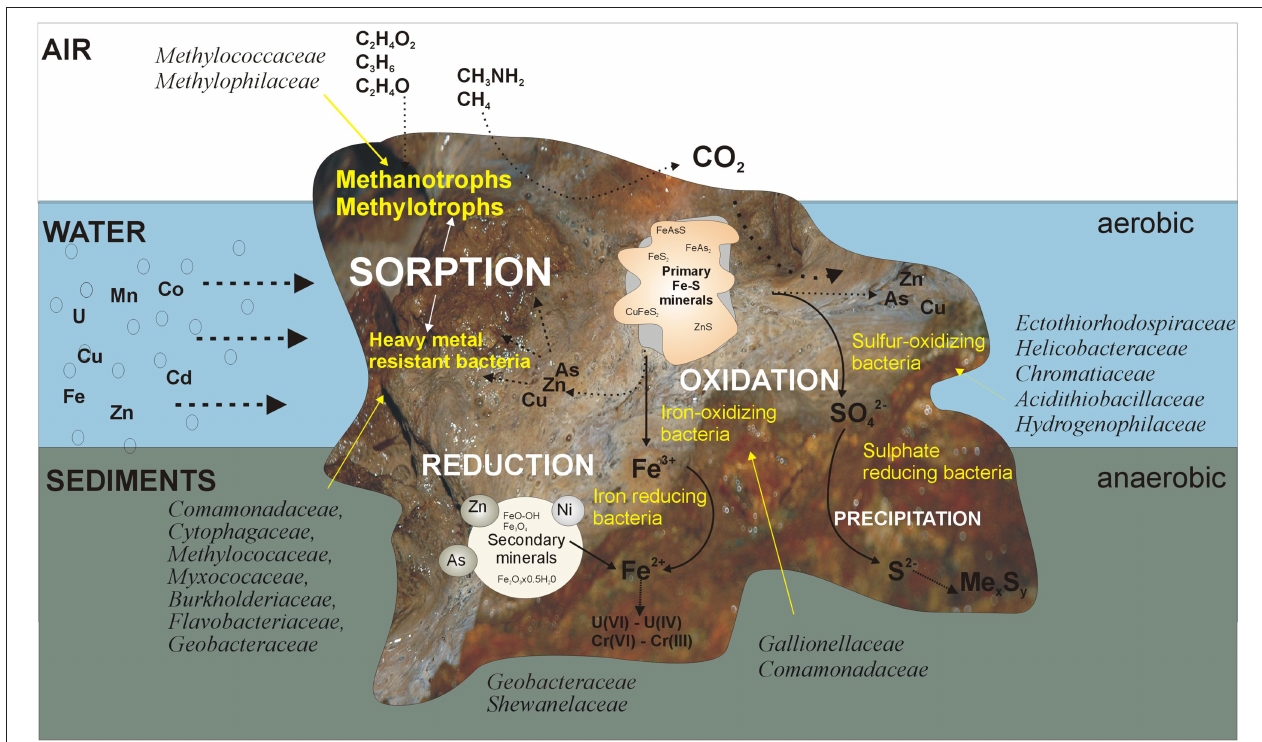
FIGURE 9 | Proposed mechanisms occurring in the mats that lead to self-purification of the mine waters. The first barrier trapping heavy metals are EPS bonded with clay minerals. Thus, the producers of an EPS matrix that are able to survive in such an extreme environment are the main driving agent responsible for sorption of heavy metals. Among them, methanotrophs play an important role, since they can utilize C1 substrates and significantly contribute to carbon cycling and energy production in this environment. Immobilization of heavy metals is also enhanced by the activity of microorganisms directly (by oxidation/reduction) and indirectly (by precipitation with sulfides) involved in metal